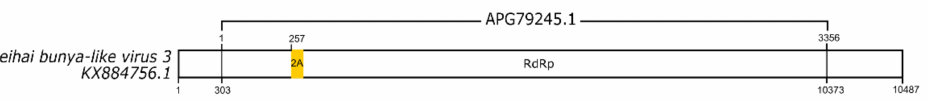
Figure 3. Schematic representation of a negative-sense single-strand RNA virus sequence. Schematic representations of nssRNA virus sequence showing the location of its respective 2A-like sequence (yellow rectangle). The nucleotide positions and size of the predicted polypeptide are represented by the numbers below and above the bars, respectively. The annotations of the viral sequence were made according to NCBI. The nucleotide and protein accession numbers are located forward and above the scheme, respectively. Representation of the genome are not to